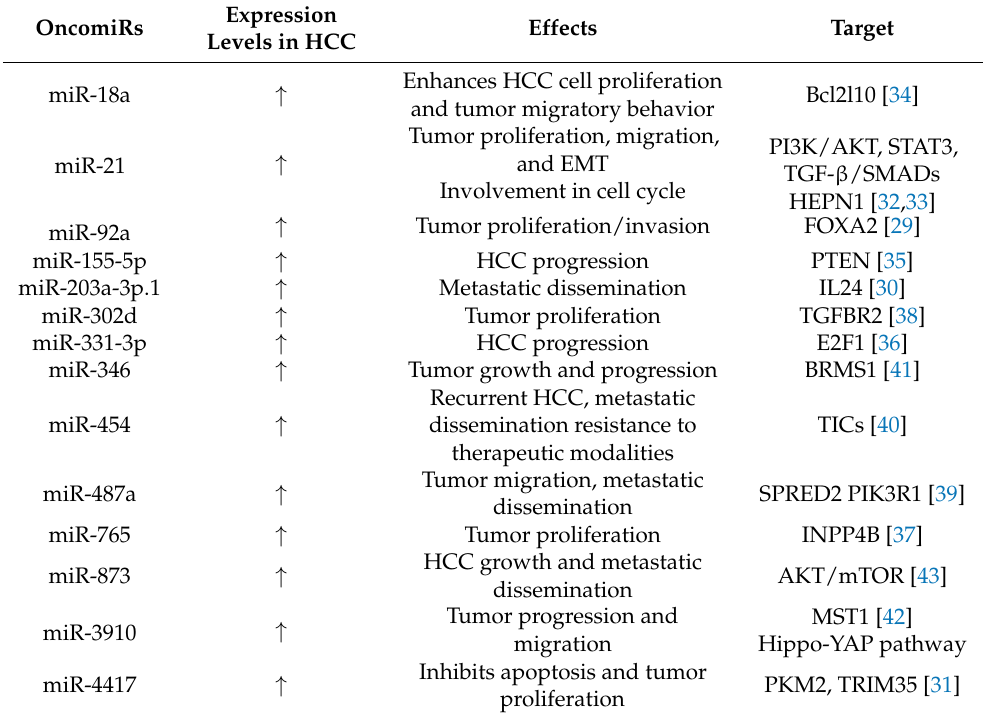
Table 1. A list of oncomiRs, their expression levels, as well as their targets and functional effects in